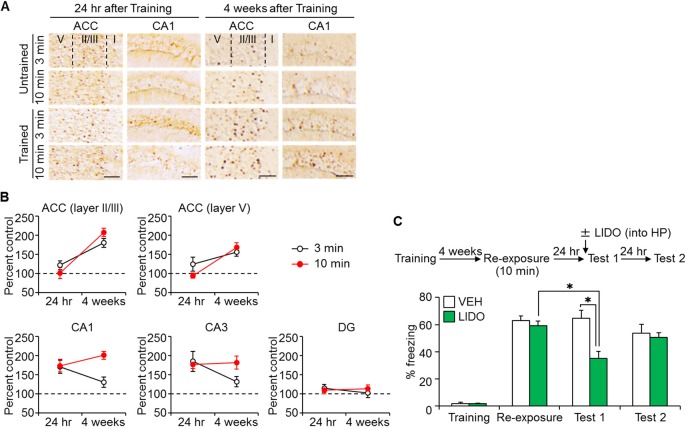
Long-time retrieval of remote fear memory reactivated the hippocampus (HP).(A) Representative immunohistochemical staining of the anterior cingulate cortex (ACC) and CA1 c-fos-positive cells from the indicated group. Scale bars = 100 μm. Two groups were trained with a foot shock (trained group) and the remaining two groups did not receive a foot shock (untrained group). Twenty-four hr (recent memory) or four weeks (remote memory) after the training, mice were placed back in the training context for 3 or 10 min for short or long memory recall, respectively (re-exposure). (B) The c-fos expression in the ACC (layers II/III, and V) and the hippocampus [CA1, CA3, and the dentate gyrus (DG) regions]. N = 10 for each group. The c-fos expression in the trained groups was expressed as a percentage relative to the untrained groups. (C) Ten min re-exposure to the context four weeks after training [vehicle-treated group (VEH), n = 11, lidocaine-treated group (LIDO), n = 11]. Error bars, SEM. *p<0.05. The results of the statistical analyses are presented in Figure 5—source data 1.DOI:
http://dx.doi.org/10.7554/eLife.17464.01110.7554/eLife.17464.012Figure 5—source data 1.Summary of statistical analyses with F values.The asterisks indicate a significant difference.